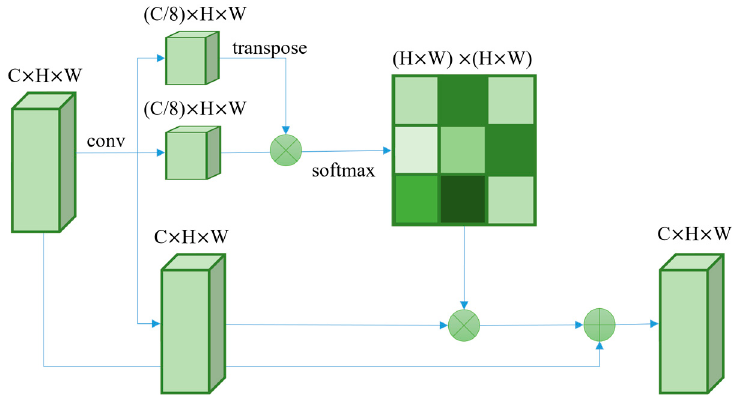
Figure 3. Architecture of Position Attention Module [18].